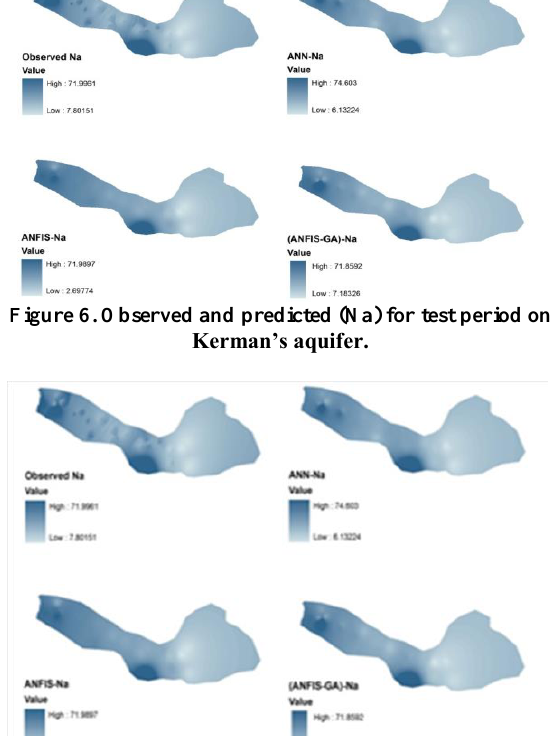
Figure 5. R 2 of chemical parameters analysis